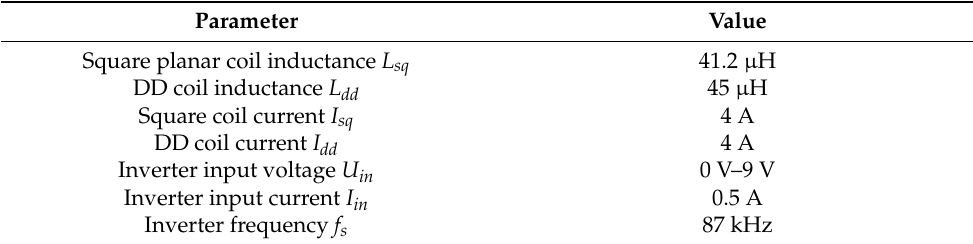
Table 2. Parameters of the test